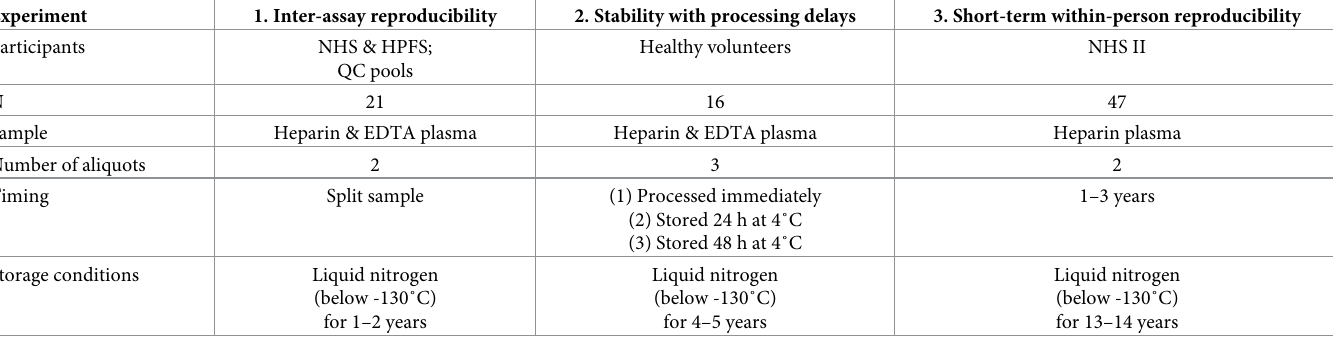
Table 1. Description of experiments for inter-assay reproducibility, stability with processing delays, and short-term within-person